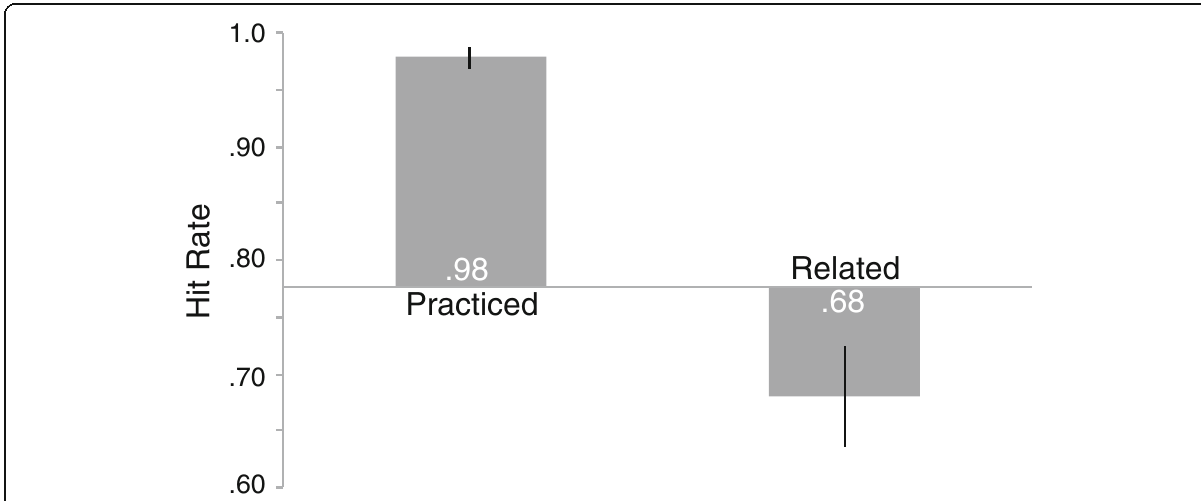
Fig. 2 Hit rate for old objects in the test phase by object type from Experiment 1. The x axis represents memory for baseline objects and error bars represent 95% confidence intervals as described by Cousineau (2005) with Morey ’ s correction applied (Morey,